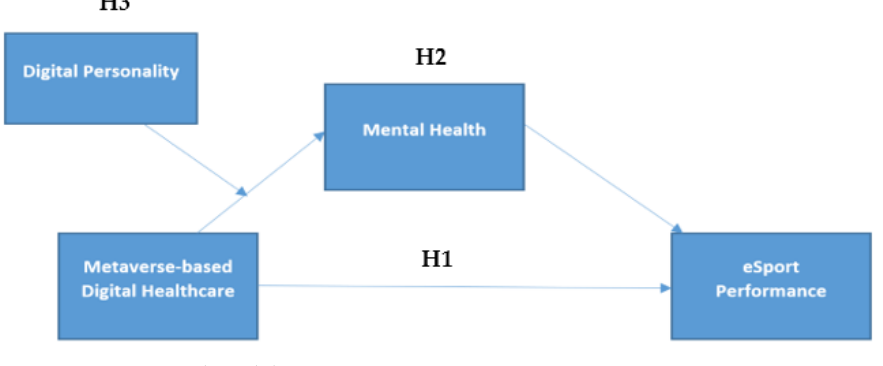
Figure 1. Conceptual